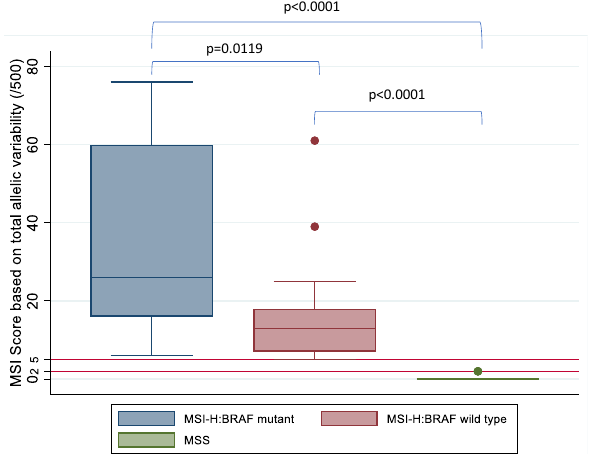
Figure 5. MSI score based on allelic instability (/500) by MSI and BRAF status confirmed on IHC and high-resolution capillary electrophoresis. Kruskal–Wallis test shows a statistically significant difference between the three subgroups based on MSI status. Horizontal red lines mark the tiers between MSS, MSI-L and MSI-H based on MSI score.